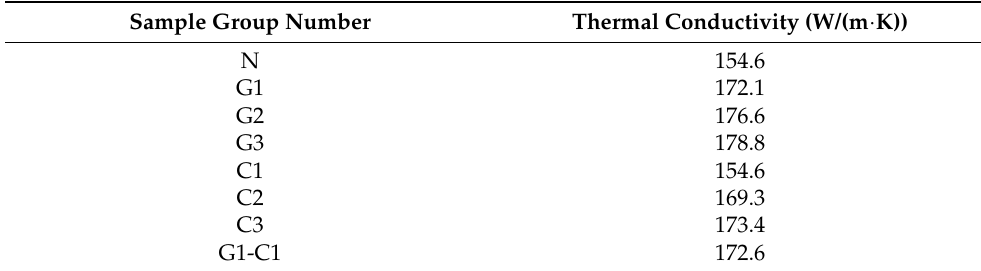
Table 8. Thermal conductivity of WC–Co cemented